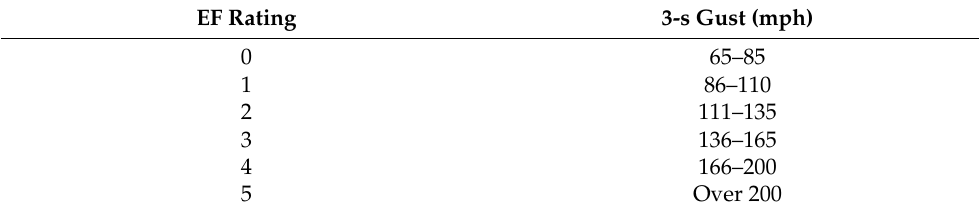
Table A1. EF rating by 3-s Gust